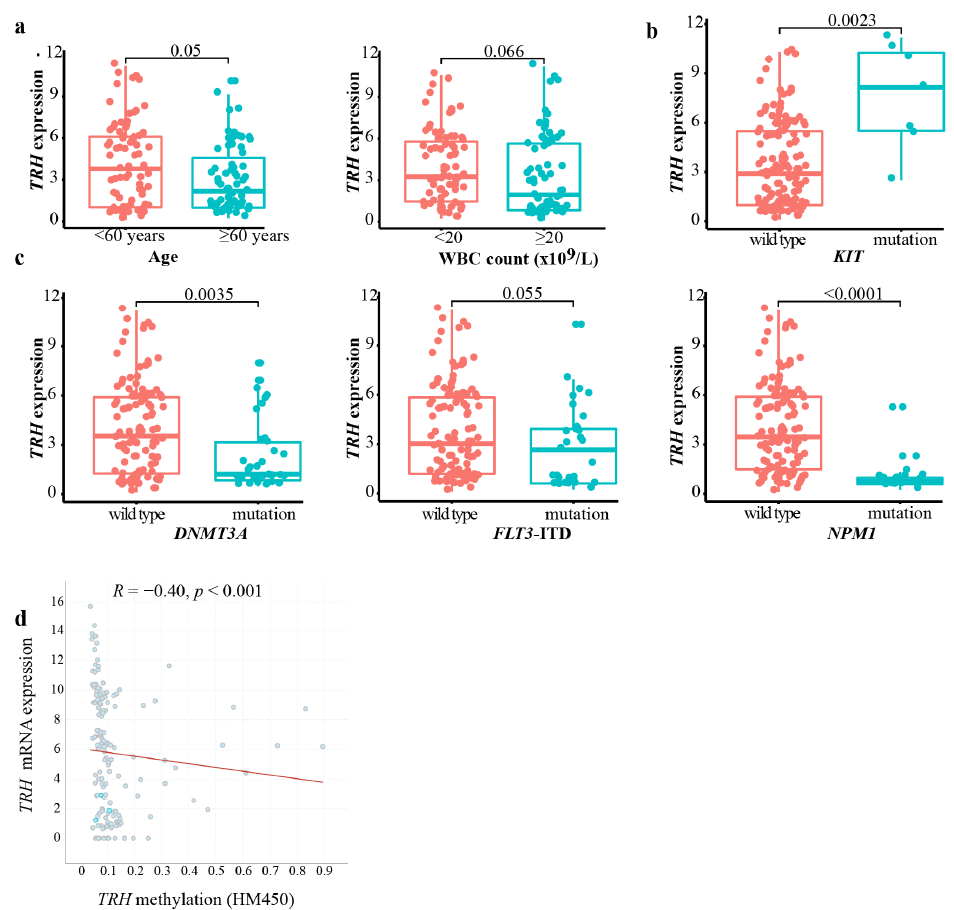
Figure 3. Clinical and genetic correlation with TRH expression in the TCGA AML dataset. ( a ) Comparison of TRH expression in different clinical subgroups of the TCGA AML dataset. ( b ) Com- parison of TRH expression in the KIT –wild-type and KIT –mutation groups of TCGA AML. ( c ) Com- parison of TRH expression in wild-type and mutation groups of DNMT3A , FLT3-ITD, and NPM1 in the TCGA AML cohort. ( d ) Correlation of methylation status (HM450) with mRNA expression of TRH in TCGA AML using cBioportal. Spearman’s correlation analysis and correlation coefficient ( R ) are